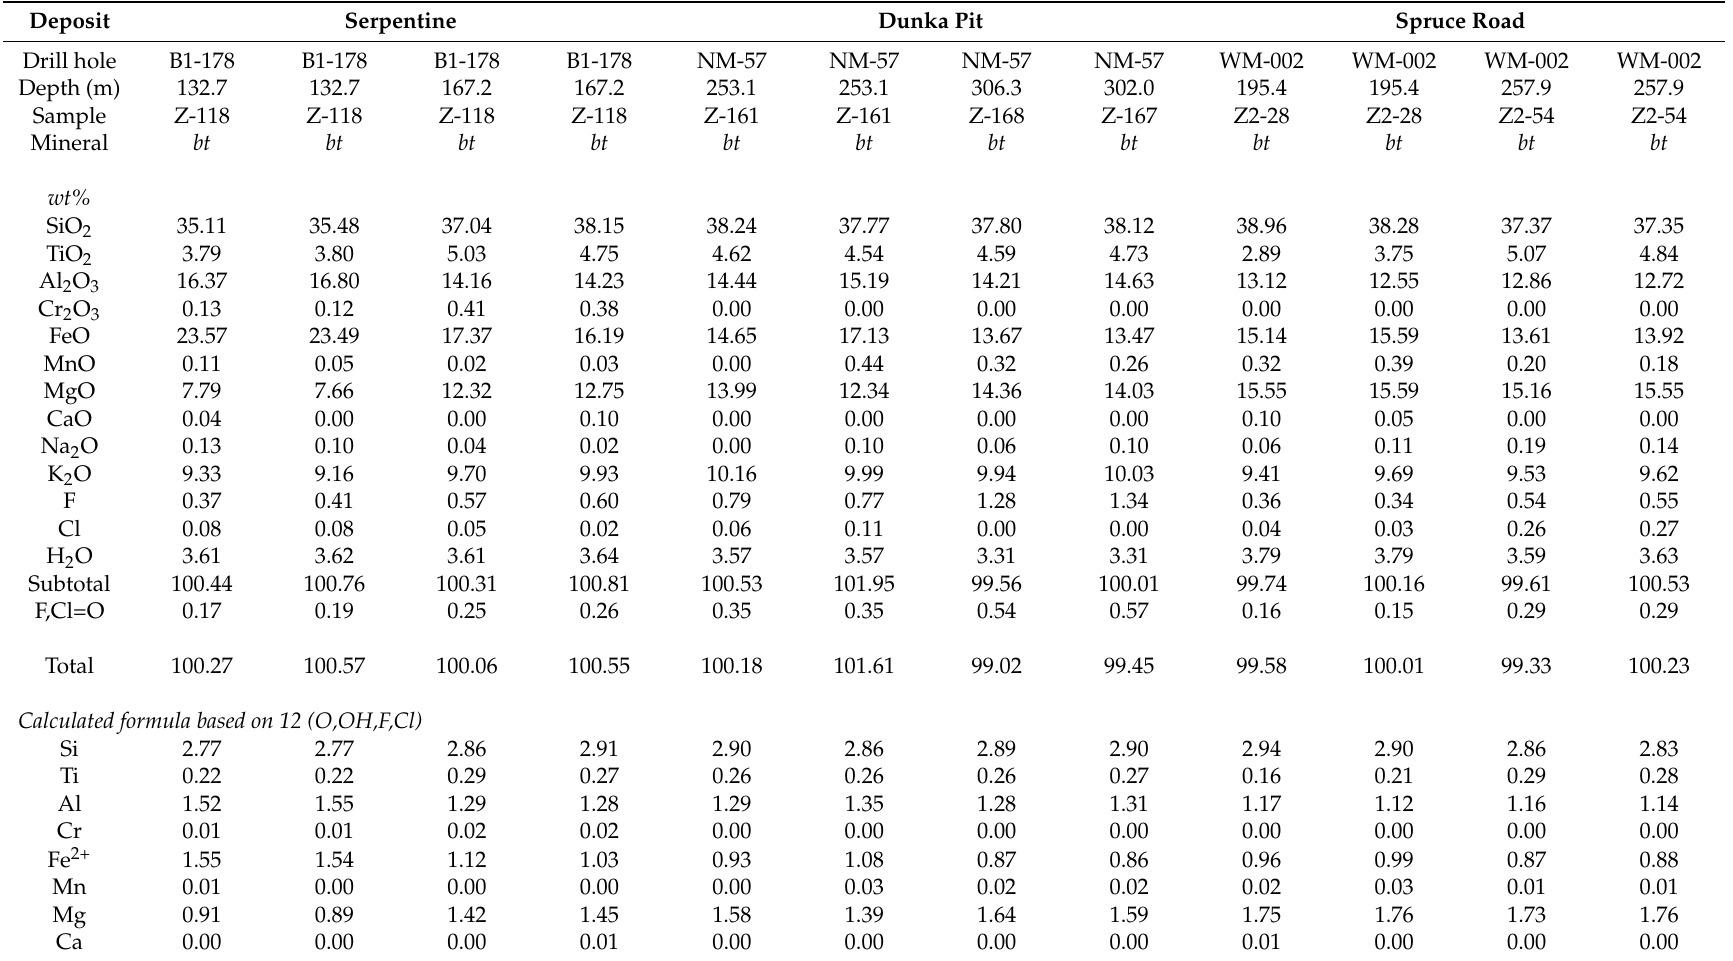
Table 3. Representative electron microprobe analyses of biotite